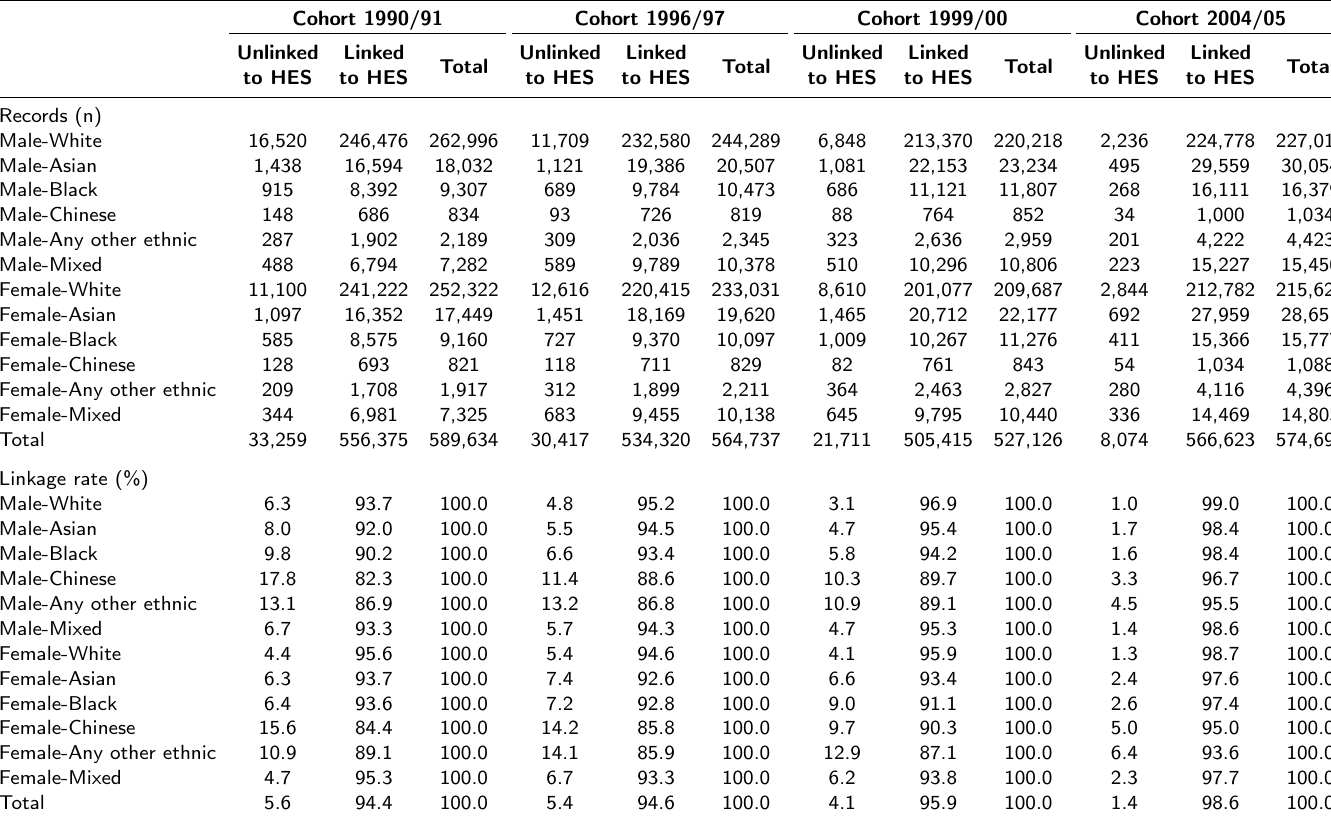
Supplementary Table 8.5: Linking rate by sex, ethnicity and